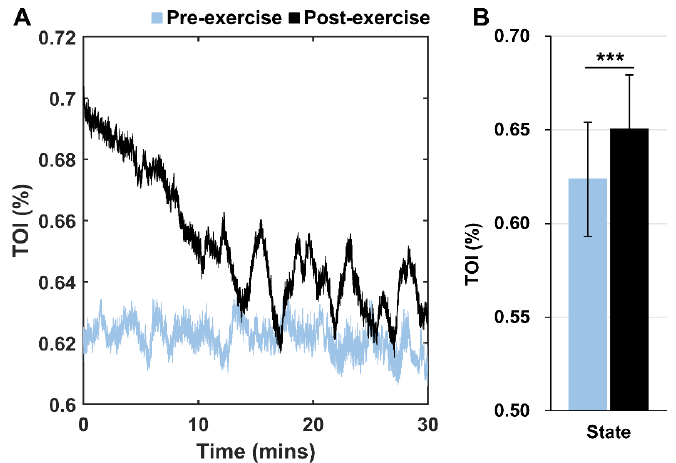
Figure 4. ( A ) Original TOI signals measured during the 30-min pre-exercise (gray line) and post-exercise (black line) rest phase. ( B ) Comparison of mean TOI values between pre-exercise (gray bar) and post-exercise (black bar) rest phase. Statistical significance: *** p <